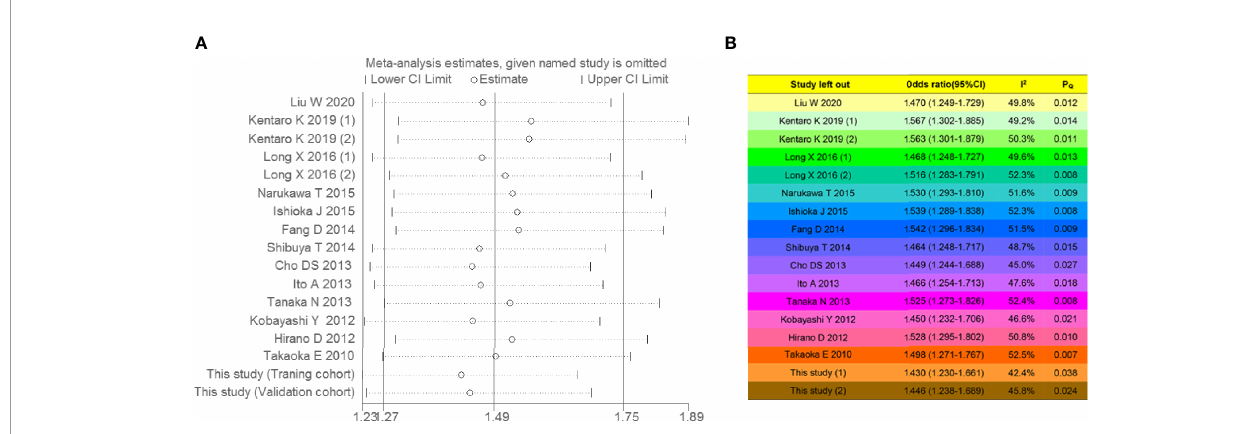
FIGURE 9 | Sensitivity analysis for intravesical recurrence-free survival. (A) Forest plot and (B) leave-one-study-out sensitivity analysis. If the P -values of the Q -test ( P Q ) were more than 0.05, the individual studies were heterogeneous. Low, moderate, and high heterogeneity corresponded to I 2 ranges of 0% – 30%, 30% – 50%, and 50% – 100%,